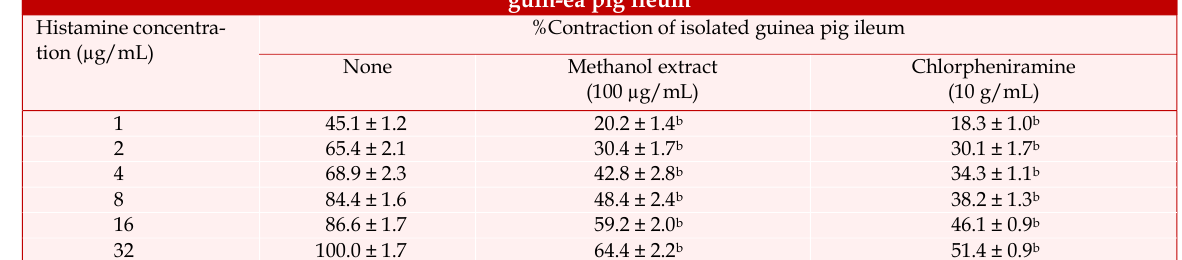
guin-ea pig ileum